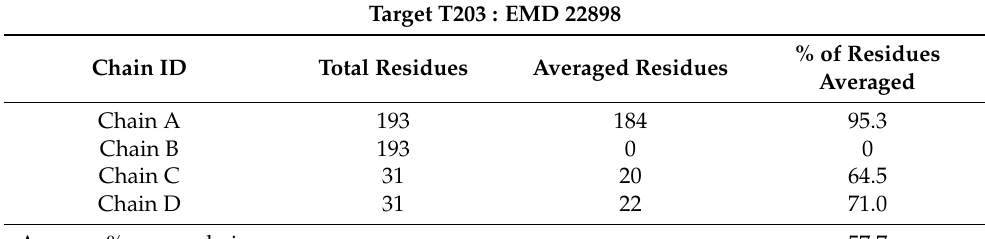
Table 3. Number of residues averaged for target T203: EMD